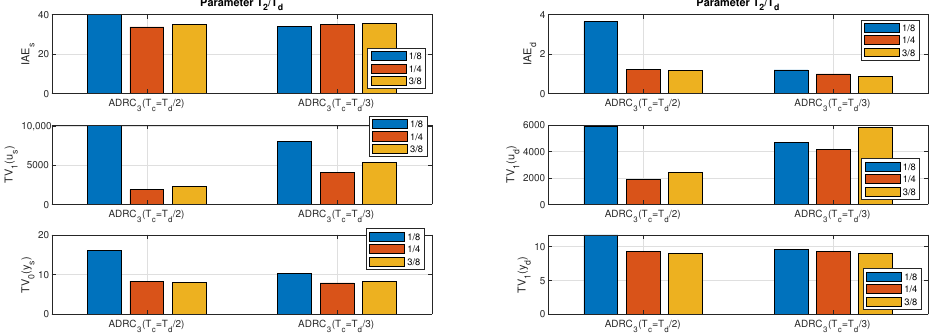
Figure 11. ADRC 3 : Performance measures corresponding to transients with “faster” ESO tuning with T c = T d /2 and T c = T d /3, T dm = T d = T d − 2 T 2